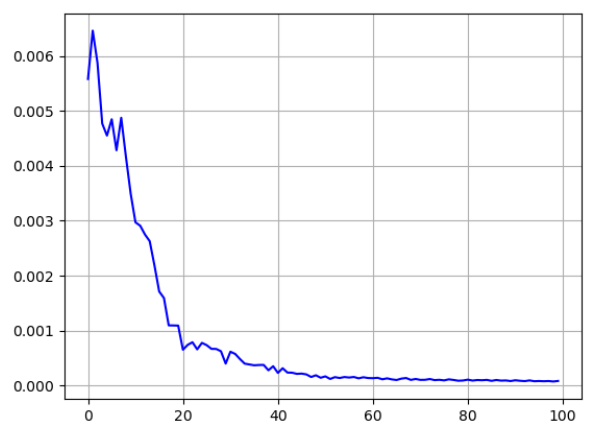
Figure 5. Example loss graph for one training period: US500 45